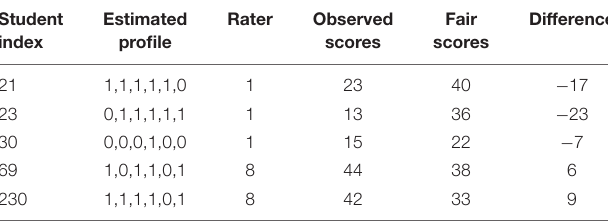
TABLE 9 | Fair scores and observed scores for selected cases in the real